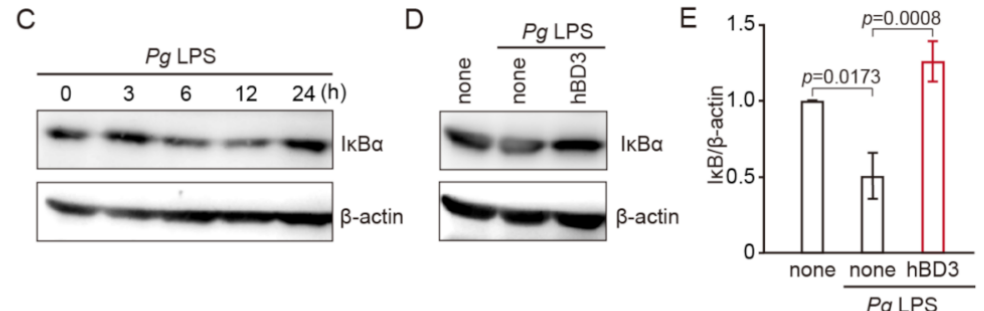
Figure 3. Effects of hBD3 on the Pg LPS-induced nuclear translocation of NF- κ B p65 and degradation of I κ B α . ( A ) Immunofluorescence CLMS images indicating the nuclear translocation of p65 (red) in MG6 cells with Hoechst-stained nuclei (blue) at 3 h after stimulation with Pg LPS (10 µ g/mL) in the presence or absence of hBD3 (1 µ M). ( B ) The typical cells were analyzed by line plot profile to show the cytosol and nuclear location of p65. ( C ) The protein expression of I κ B α in MG6 cells after stimulation with Pg LPS (10 µ g/mL) at the indicated time. ( D ) The protein expression of I κ B α in MG6 cells after stimulation with Pg LPS (10 µ g/mL) for 6 h in the presence or absence of hBD3 (1 µ M). ( E ) The mean intensity of I κ B α , which were detected by the immunoblots shown in ( D ), were measured and normalized against the signal of β -actin. They are shown here relative to the values in untreated cells. The data are presented as the mean ± SE of five independent experiments from MG6 cells after stimulation with Pg LPS for 6–24 h in the presence or absence of hBD3, and p values were calculated using a one-way ANOVA with a post-hoc Tukey’s test. A value of p < 0.05 was considered to indicate statistical